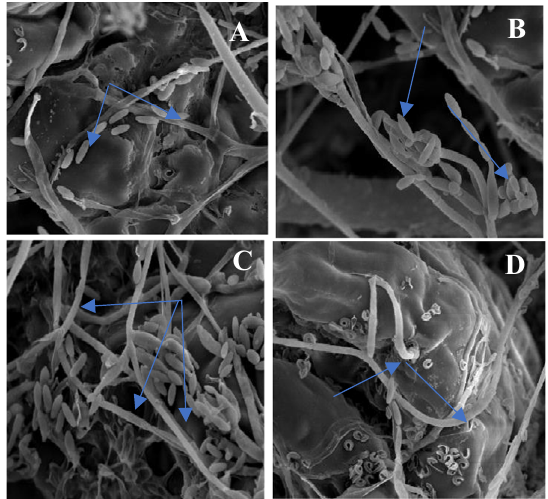
Fig. 5 Scanning electron microscopy (SEM) of the nymph of Bemisia tabaci infected with Isaria javanica at 8 days post-inoculation A Conidia of I. javanica attached to the body of B . tabaci B Germinated conidia of I. javanica C Mycelium growing on the integument of infected nymph D Hyphal penetration of I. javanica into the integument of an infected nymph of B. tabaci